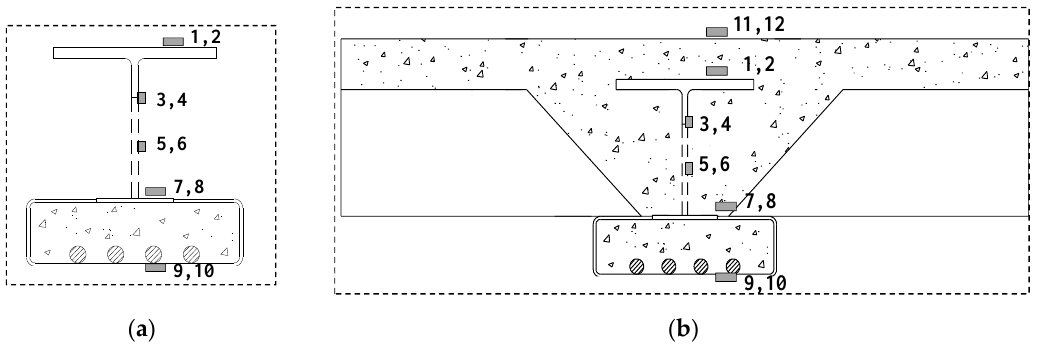
Figure 7. Strain gauge locations: ( a ) non-composite specimens; ( b ) fully composite specimens.